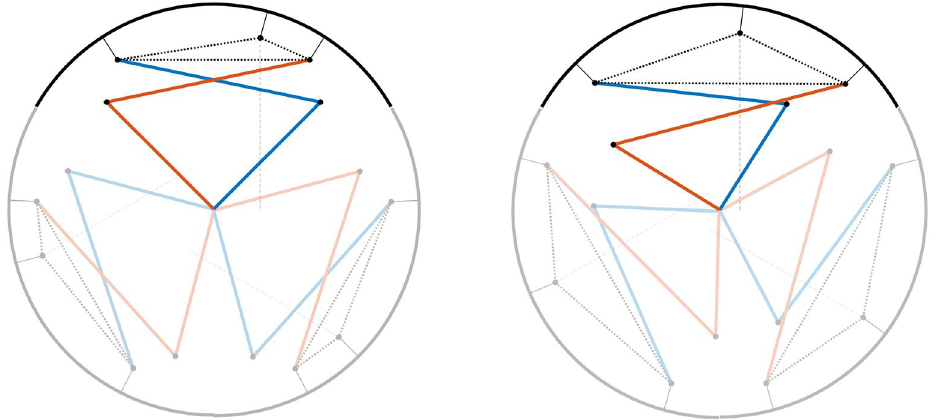
Figure 11. (Right)The schematic of the full wheel with one part of the lobe highlighted. (Left)The The proposed optimum linkage design set visualized. The shape of the wheel in full assembly can be seen with this diagram. There is no interference with other parts of the wheel, making proving this set to be plausible to